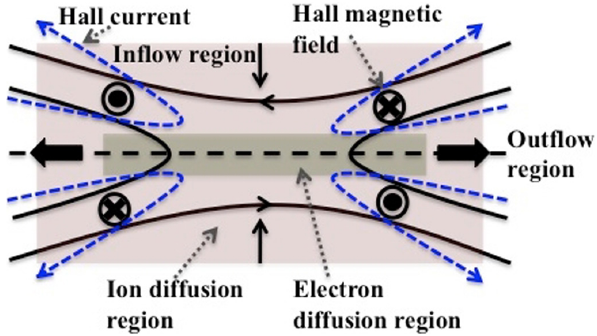
Fig. 1. 2-D cartoon of magnetic reconnection, see text for explanations.